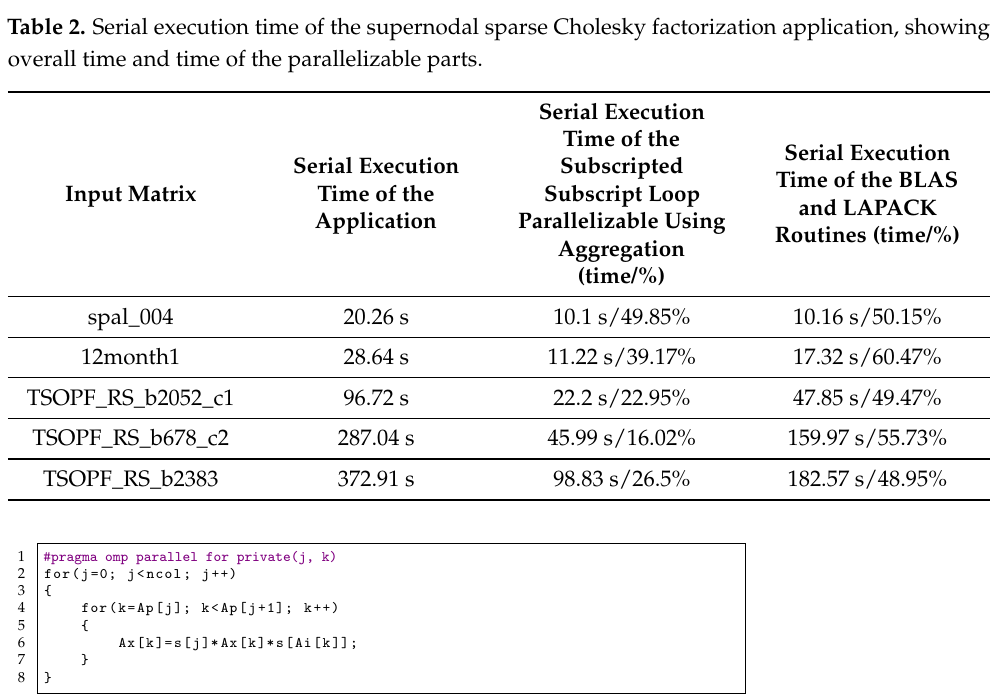
Figure 8. Example loop to parallelize. This loop performs symmetric scaling of a sparse matrix A by a scaling factor s , where s is a diagonal vector. The outer loop can be parallelized if array Ap is monotonically increasing.